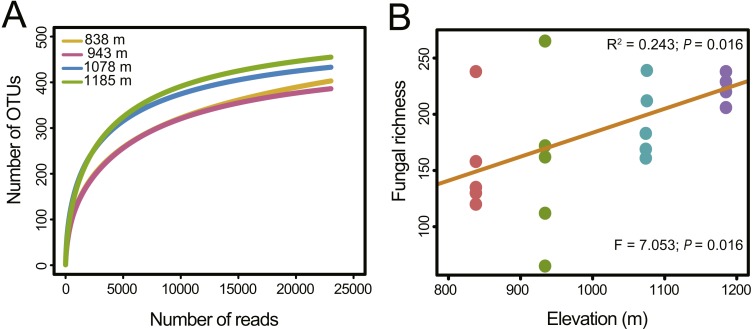
Fungal richness along the elevation gradient.(A) OTU accumulation curves of the phyllosphere fungal communities at four elevation sites. (B) OTU richness of phyllosphere fungal communities at each site. The results from the linear regressions and the one-way analysis of variance (ANOVA) are indicated in the upper and lower part of the figure, respectively.